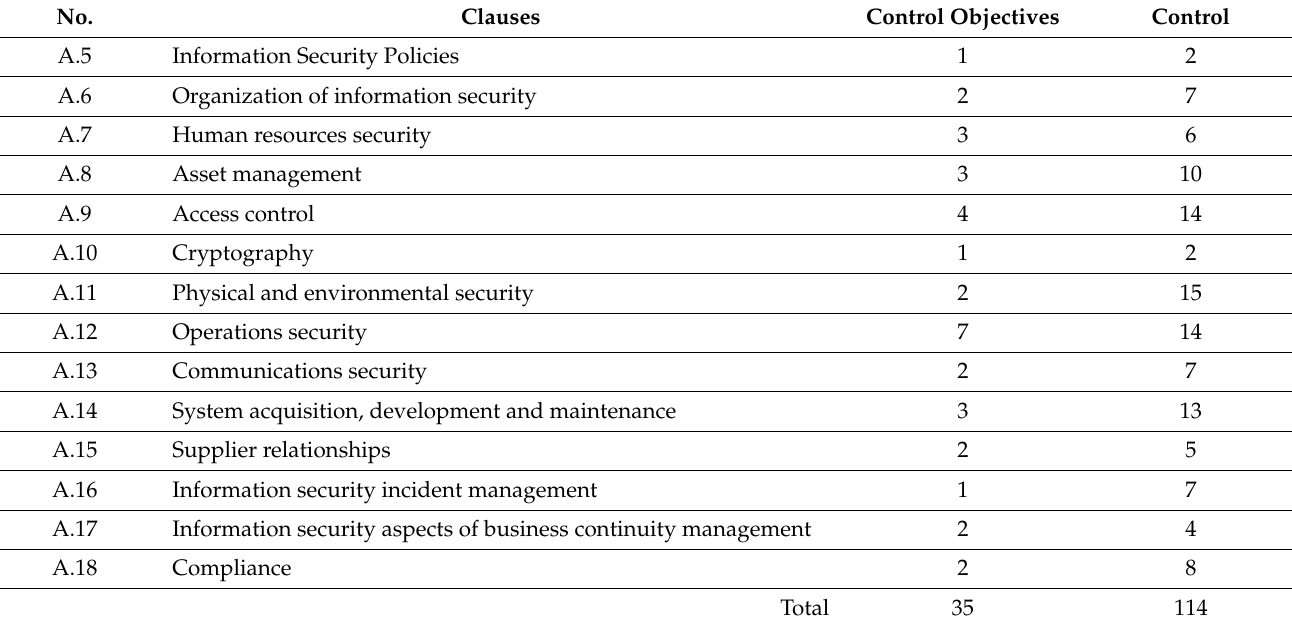
Table 2. Control of Annex ISO 27001:2013 (ISO/IEC 27001:2013